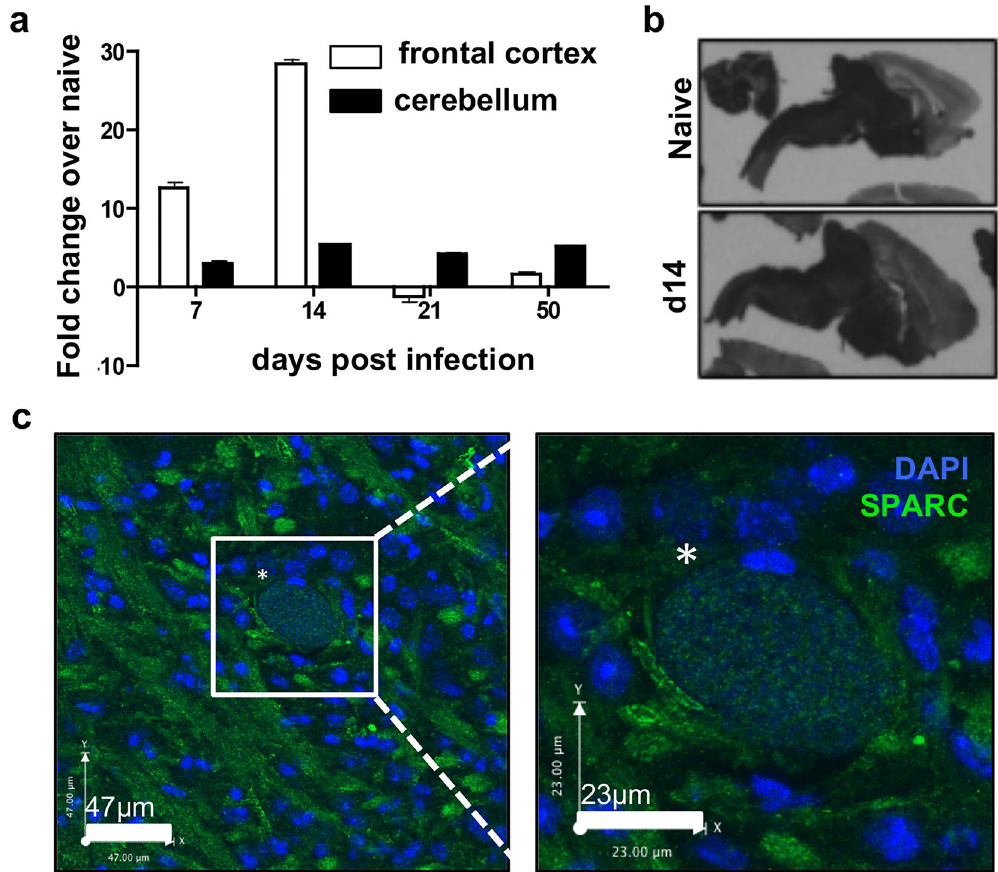
Figure 2. Expression of SPARC in the CNS during chronic T. gondii infection. ( a – c ) C57Bl/6 mice were infected with the Me49 strain of T. gondii and sacrificed at various timepoints. ( a ) Frontal cortex and cerebellum of infected brains were removed at days 7, 14, 21, and 50 post-infection. RNA was isolated, reverse transcribed and analyzed for levels of SPARC transcripts using qRT-PCR. Results are shown as fold change over naïve normalized to HPRT. n = 3 mice per group. Data are represented as mean ± SEM. ( b ) Brains were removed from naïve and 14 day infected mice. In-situ hybridization was performed on brain slices with probes specific to SPARC mRNA. ( c ) Confocal fluorescence microscopy of 20 μm brain slices taken from mice at 3 weeks post infection. Image and inset show a parasite cyst (*) identified by punctate DAPI (blue) stain surrounded by parenchymal SPARC